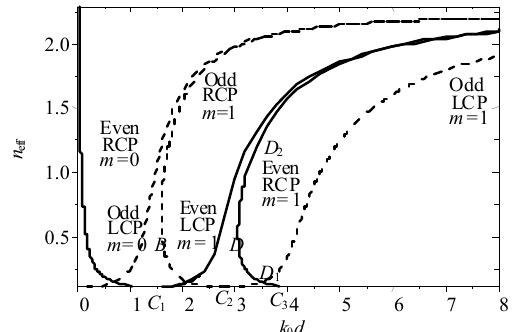
Fig. 2 Dispersion curves of guided modes in the chiral nihility cladding and negative-index material core waveguide.